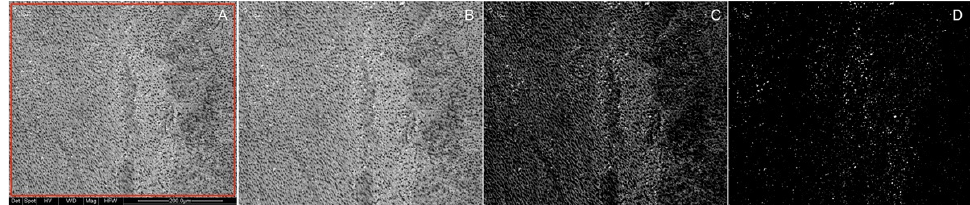
Figure 2. ( A ) Original SEM image where measures were performed; the red square shows where the image is cropped as seen in ( B ). ( C ) Enhancement of contrast highlighting white dots corre- sponding to CH particles, ( D ) image after